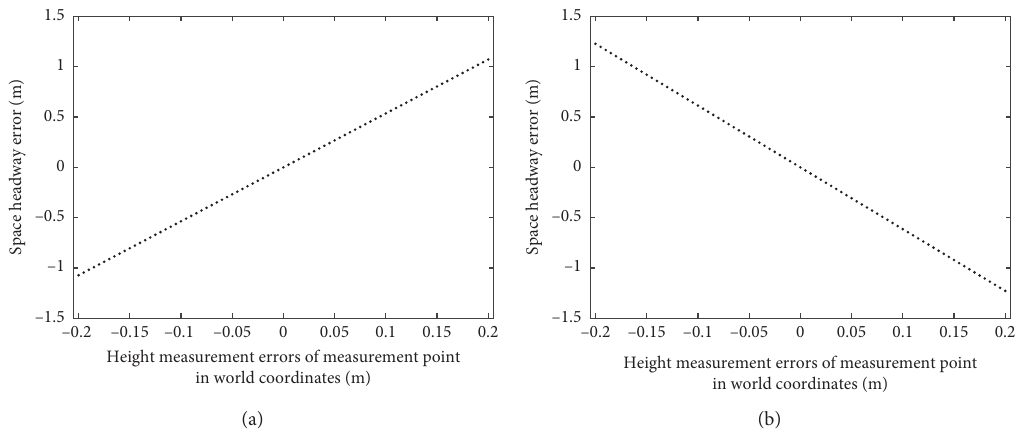
Figure 9: Distribution of errors in space headway estimation when a height measurement offset of a measurement point on a different vehicle is introduced: (a) measurement point on the preceding vehicle and (b) measurement point on the following Table 4: Characteristics of space headway estimation errors with height measurement offset of the measurement points on different vehicles. Location of altered measurement point